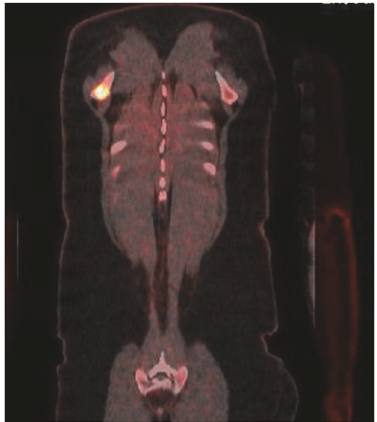
Figure 1: FDG avid lesion in right scapular bone.